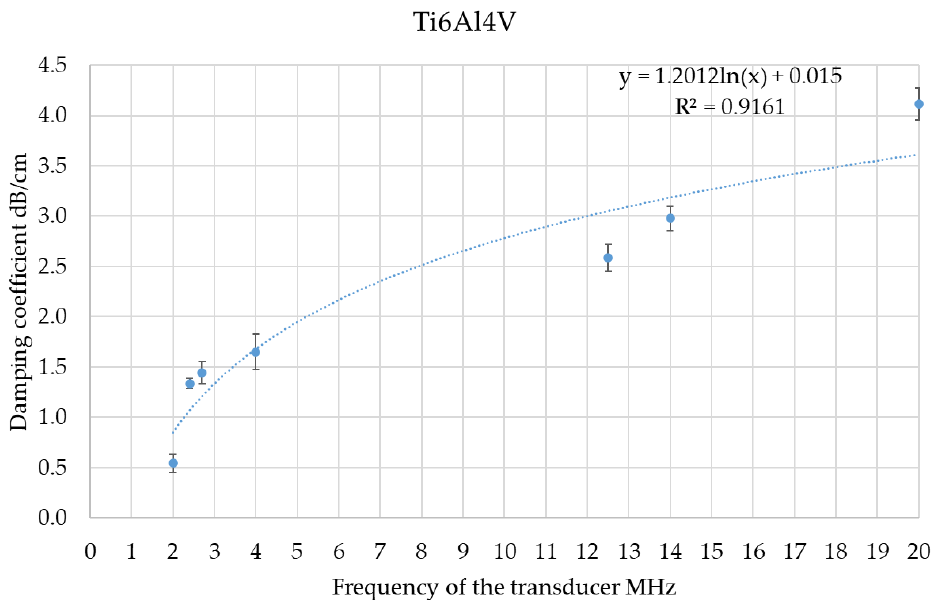
Figure 4. Dependence of the ultrasonic transducer frequency on damping coefficient for Ti6Al4V material.